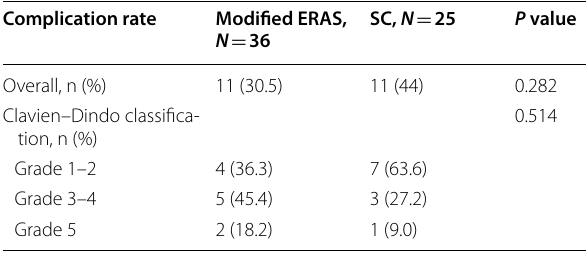
Table 5 Comparison of complication